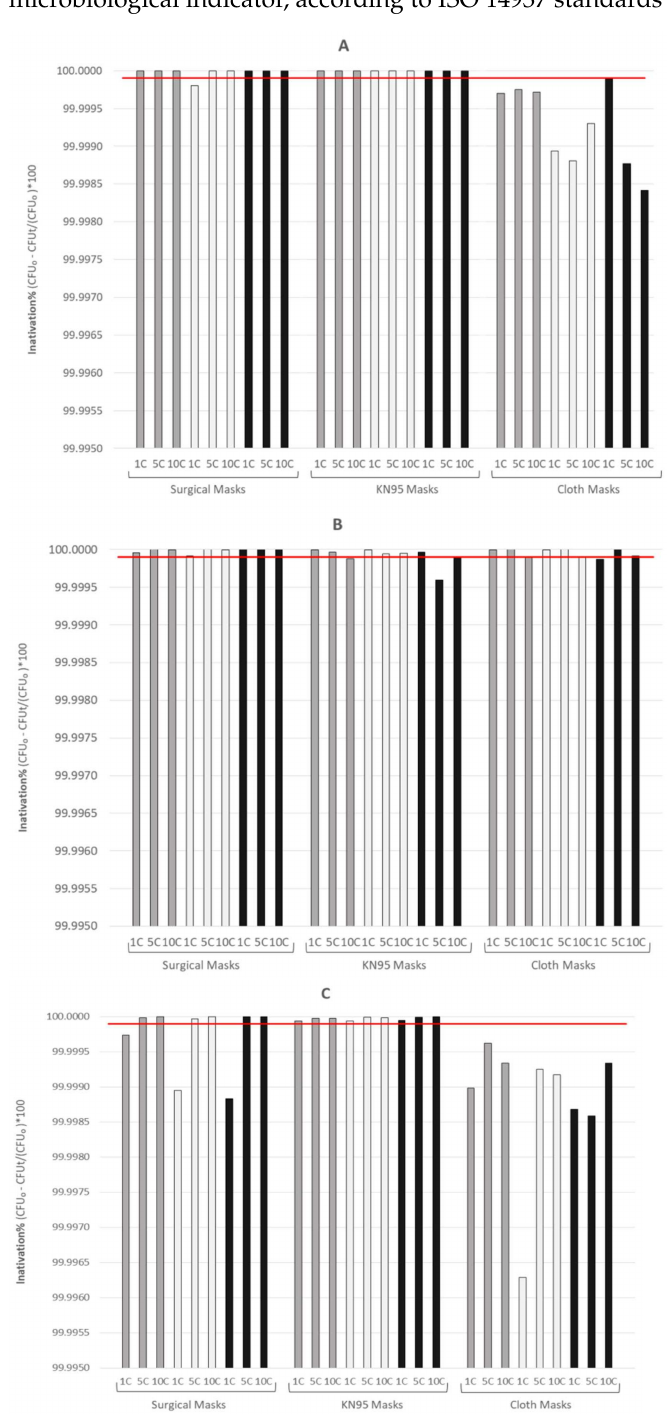
Figure 3. Effectiveness of endospores’ inactivation using three different endospores number suspen- sions (10 7 (black bars), 10 8 (grey bars), and 10 9 (white bars)) by the three decontamination processes for surgical, KN95 and cloth masks: nebulized hydrogen peroxide ( A ), immersion in commercial bleach ( B ) and contact with microwave-generated steam ( C ). The red line indicates the Standard Effectiveness established in ISO 14937 (corresponding to a reduction of six orders of magnitude in the CFUs). The inactivation values were obtained through the ratio between the difference of the inoculated CFUs and the CFUs recovered after treatment and the total inoculated